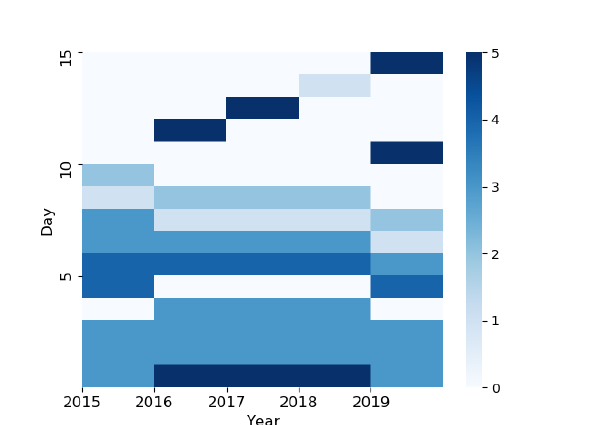
Figure 22: Clustering output for humidity for first 15 days in Q 1 over 2015 to 2019.